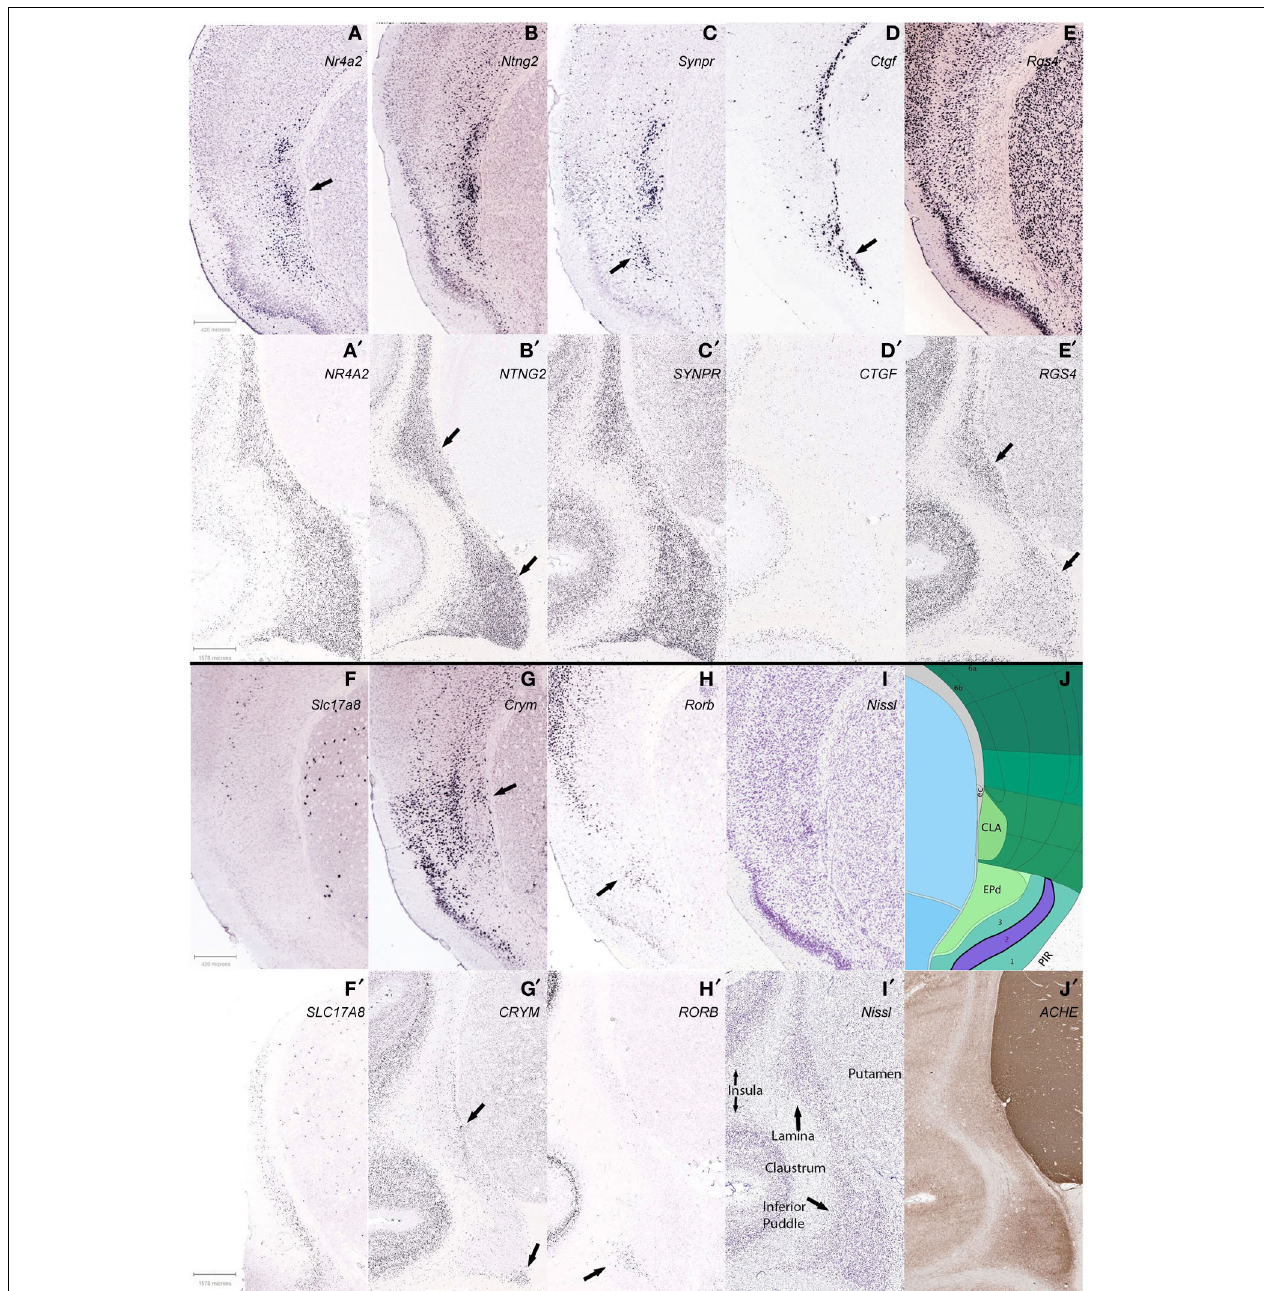
FIGURE 7 | Differential claustrum expression patterns within and between species, C57/B6 mice in 1st and 3rd panels (A–J), Macaque monkey Macaca mulatta in 2nd and 4th panels (A (cid:2) –J (cid:2) ). (A) Nr4a2 expression forms a dense core (arrow) surrounded by diffuse staining, with another dorsal cluster that is also found with Ntng2 and Synpr labeling (B,C) and reciprocally in Crym (G) . (D,D (cid:2) ) Ctgf labeling of cortical layer 6b and deeper endopiriform nucleus (EPd), with a stream of cells that subtend the claustrum in mouse (arrow), and only deep cortex and non-neuronal appearing cells lightly labeled in macaque. (E,E (cid:2) ) Rgs4 labeling avoids the mouse claustrum yet labels most other regions, but staining in macaque shows a species difference. (F,F (cid:2) ) Slc17a8 shows another stark species difference in claustral expression, with no apparent expression in mouse and many cells expressing in macaque. (G,G (cid:2) ) Crym expression in mouse largely